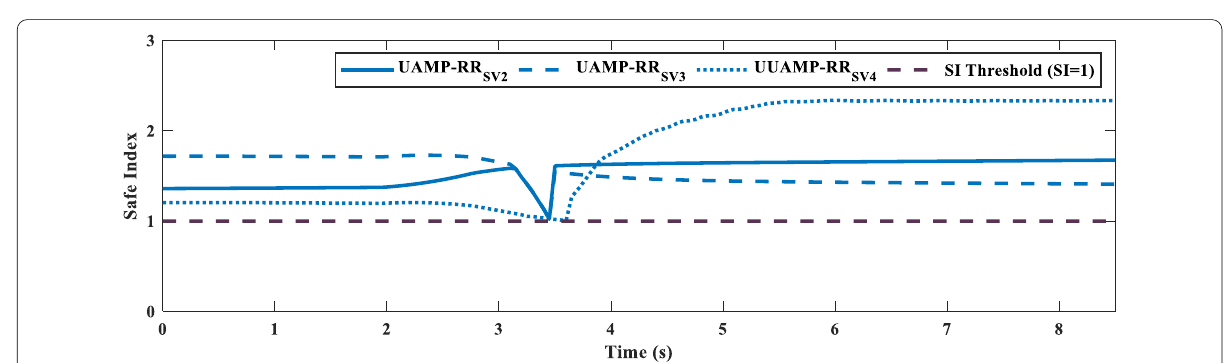
Figure 13 SI values of UAMP-RR for other SVs in case 2